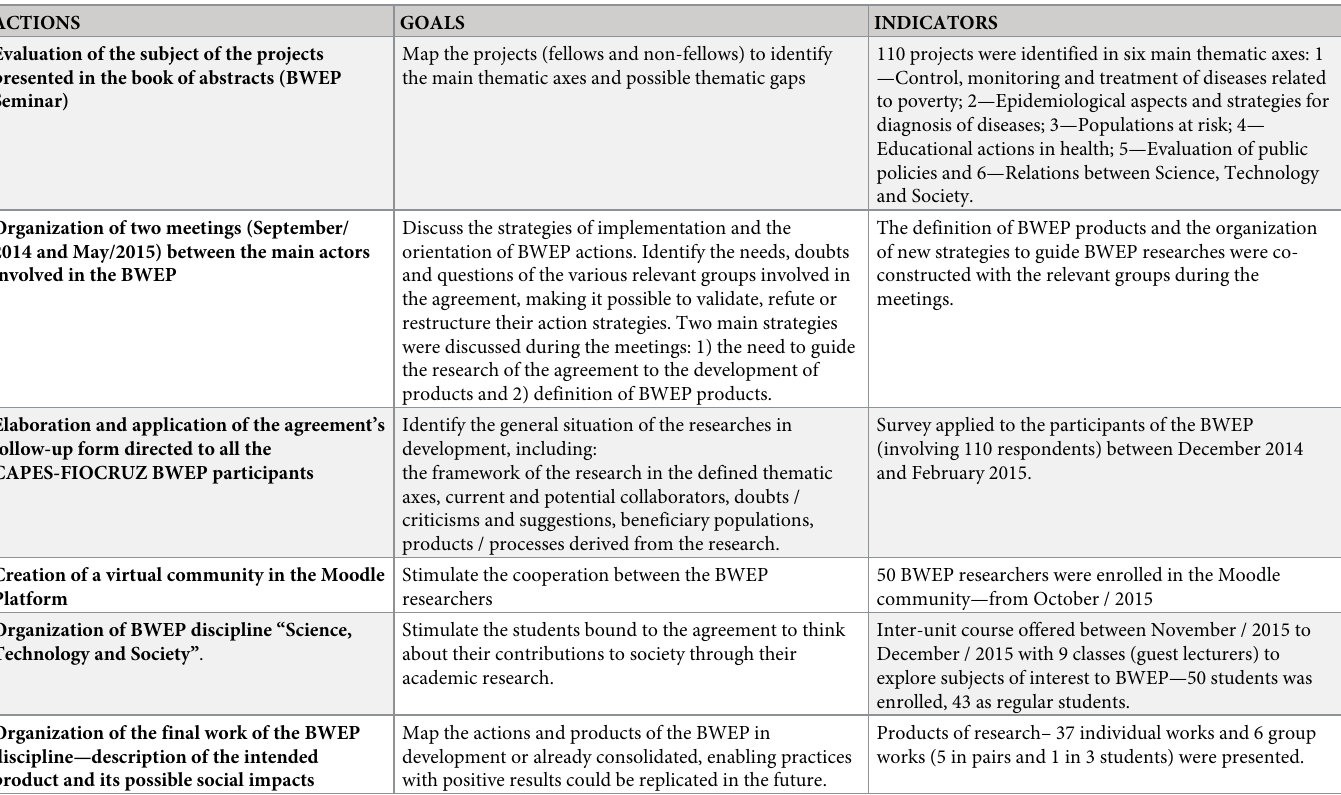
Table 1. Strategic actions that were developed to supervise and manage BWEP program in FIOCRUZ. ACTIONS